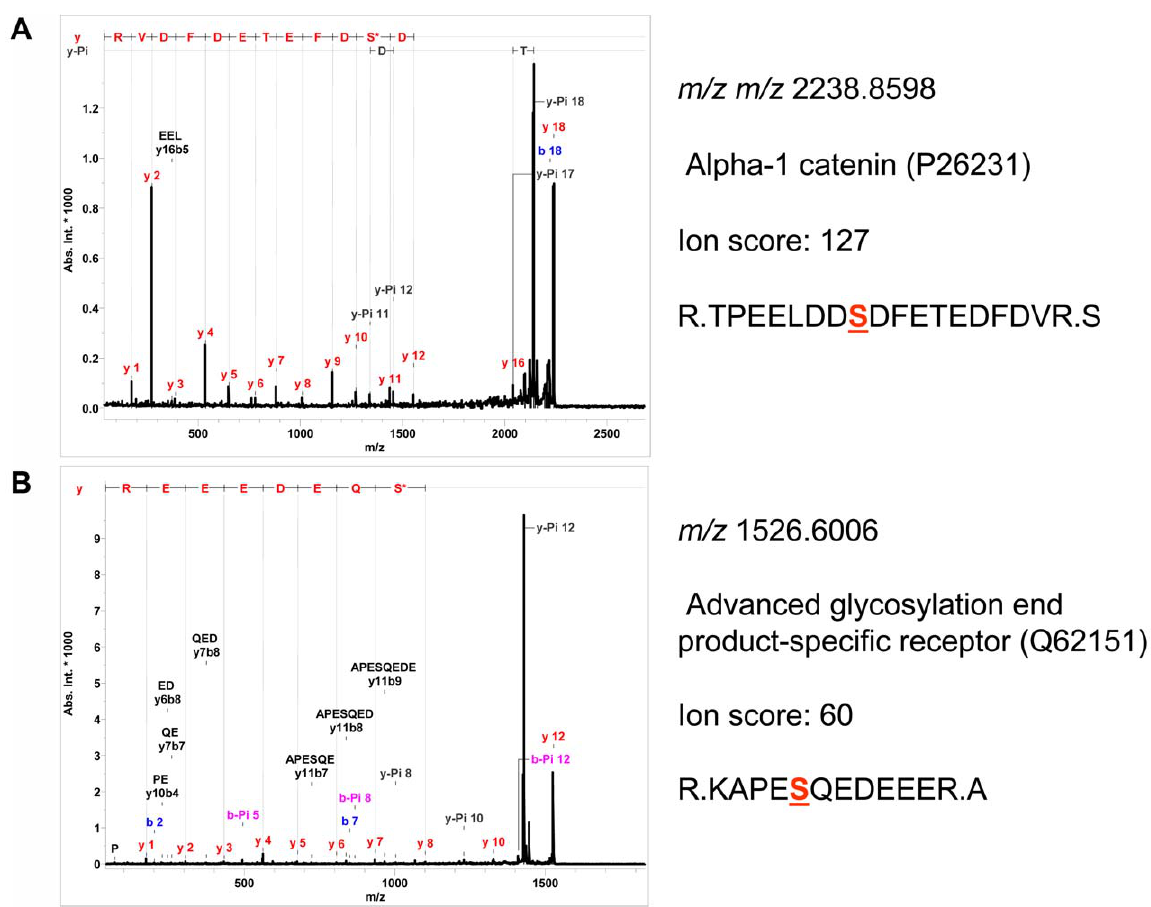
Figure 5. MALDI-TOF MS/MS of phosphopeptides. Characterization of phosphorylation sites of phosphorylated peptides by MALDI-TOF-MS/ MS.